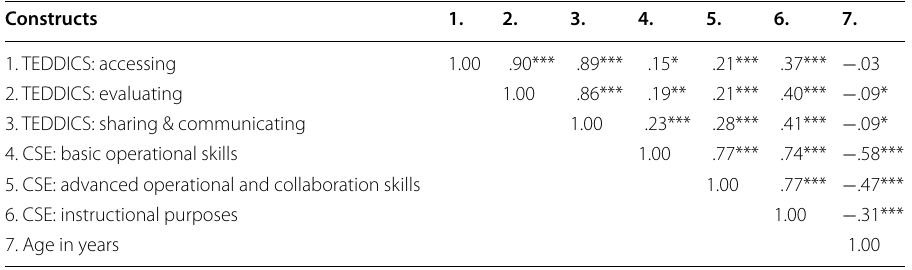
Correlations among latent variables are reported. N